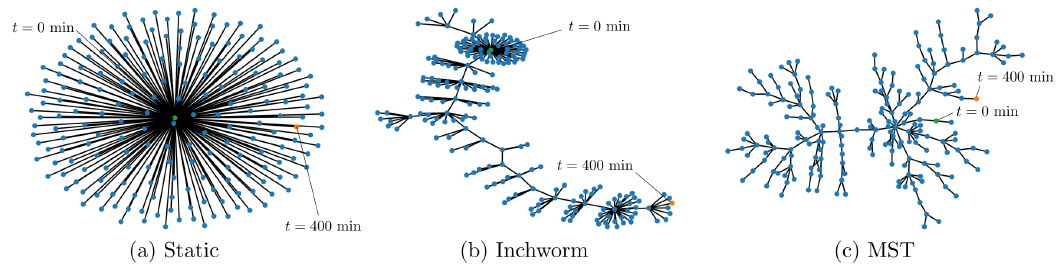
Figure 4. Examples of graphs generated from a heated SMF-28 optical fiber using a static reference ( a ), the inchworm algorithm [31] ( b ), and a maximum spanning tree (MST) algorithm ( c ). The node representing the initial measurement ( t = 0 min) is shown in yellow, and the final measurement ( t = 400 min) is shown in green.